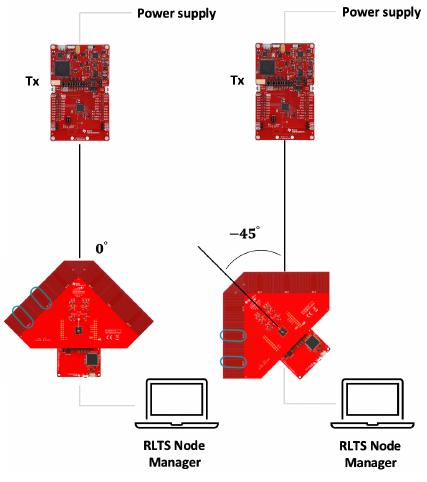
Figure 12 . Placement of BLE devices at the angle of 0°,